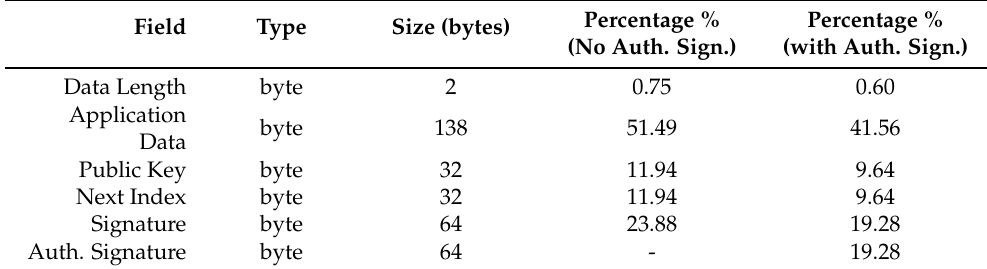
Table 3. Detailed size of the fields embedded in a L2Sec